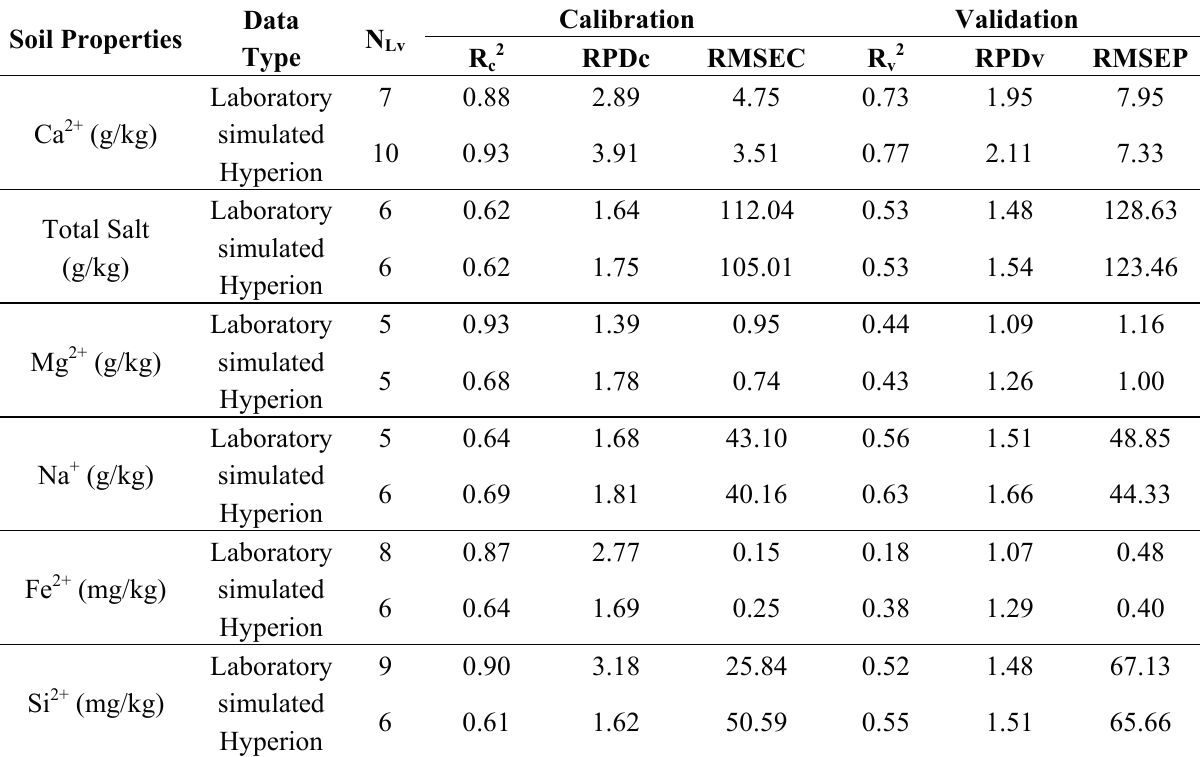
Table 2. Statistical parameters resulting from partial least squares (PLS) calibration and validation with laboratory and simulated Hyperion